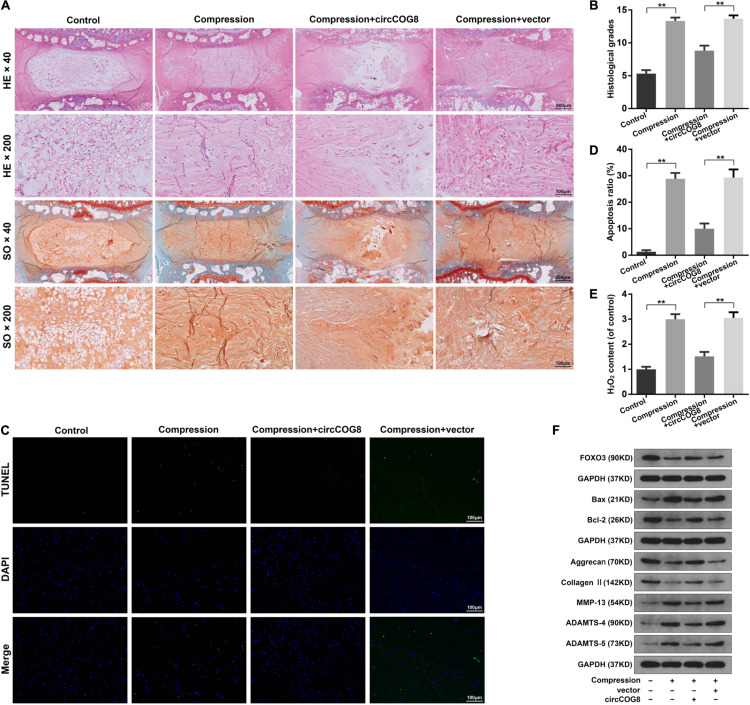
CircCOG8 overexpression attenuated the compression-induced IDD ex vivo.
(A) Representative photograph of the rat IVD tissues stained with HE and SO. The images were scanned at × 40 magnification (scale bar = 500 μm) and × 200 magnification (scale bar = 100 μm). (B) The histological grades of the disk samples evaluated by the histological grading scale. (C) Representative photograph of the TUNEL analysis to examine the NP cell apoptosis (scale bar = 100 μm). (D) Quantitative analysis of the TUNEL-positive cells indicating the apoptosis ratio. (E) The H2O2 content in the IVD tissues indicating the ROS level. (F) Western blot analysis was used to determine the protein expression level of FOXO3, Bax, Bcl-2, Aggrecan, Type II collagen, MMP-13, ADAMTS-4, and ADAMTS-5. The upper GAPDH band served as an internal loading control for FOXO3; the middle GAPDH band served as a common internal loading control for Bax and Bcl-2; the lower GAPDH band served as a common internal loading control for Aggrecan, Type II collagen, MMP-13, ADAMTS-4, and ADAMTS-5. Data were represented as mean ± SD. *p < 0.05, **p < 0.01, n = 6 IVDs per group (Student’s t-test).